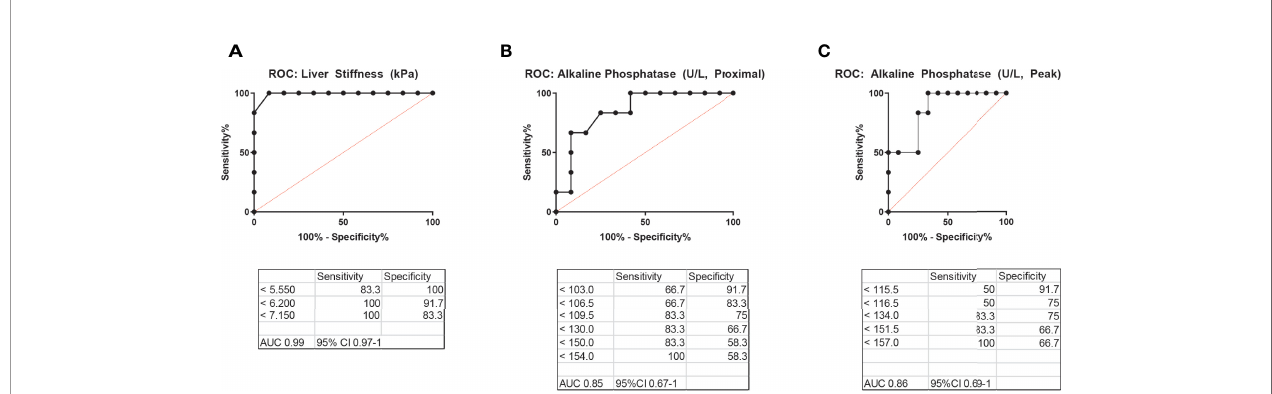
FIGURE 4 | Receiver operating characteristic (ROC) curves for the diagnosis of NRH in CVID patients. ROC curves for (A) liver stiffness by transient elastography, (B) alkaline phosphatase (ALP) level in peripheral blood most proximal to the time of transient elastography, and (C) peak ALP level in peripheral blood, excluding acute illness, to diagnose NRH in patients with CVID. AUC, area under the curve; NRH, nodular regenerative hyperplasia; CVID, common variable immunode